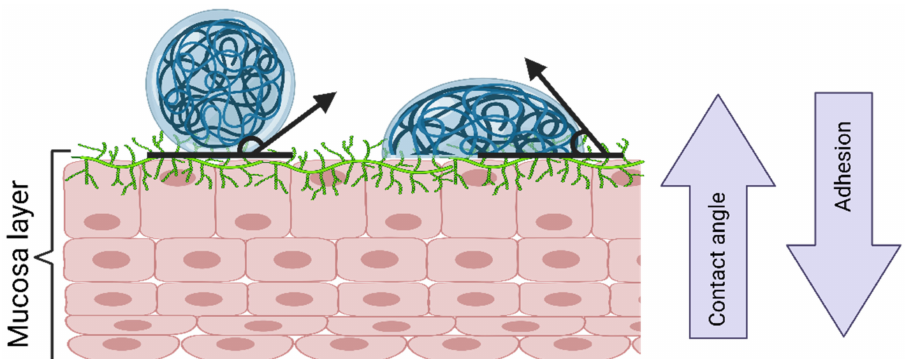
Figure 8. The wetting theory according to contact angle. Created with BioRender.com Adapted